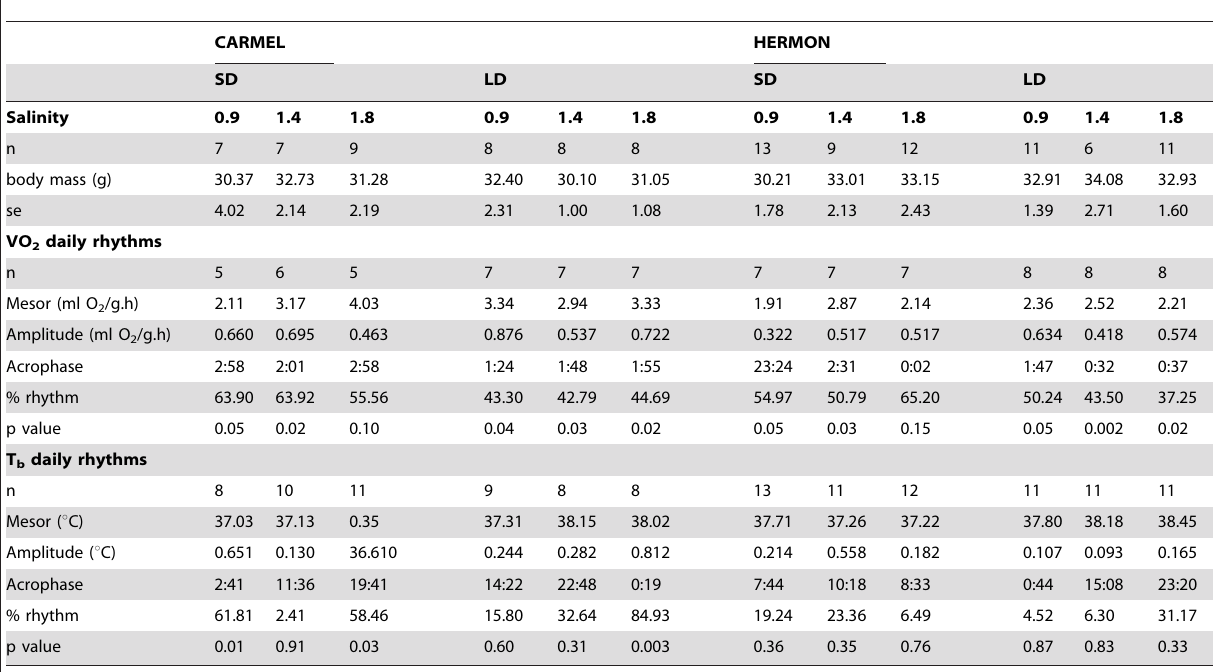
Table 1. Daily rhythms of oxygen consumption and body temperature.